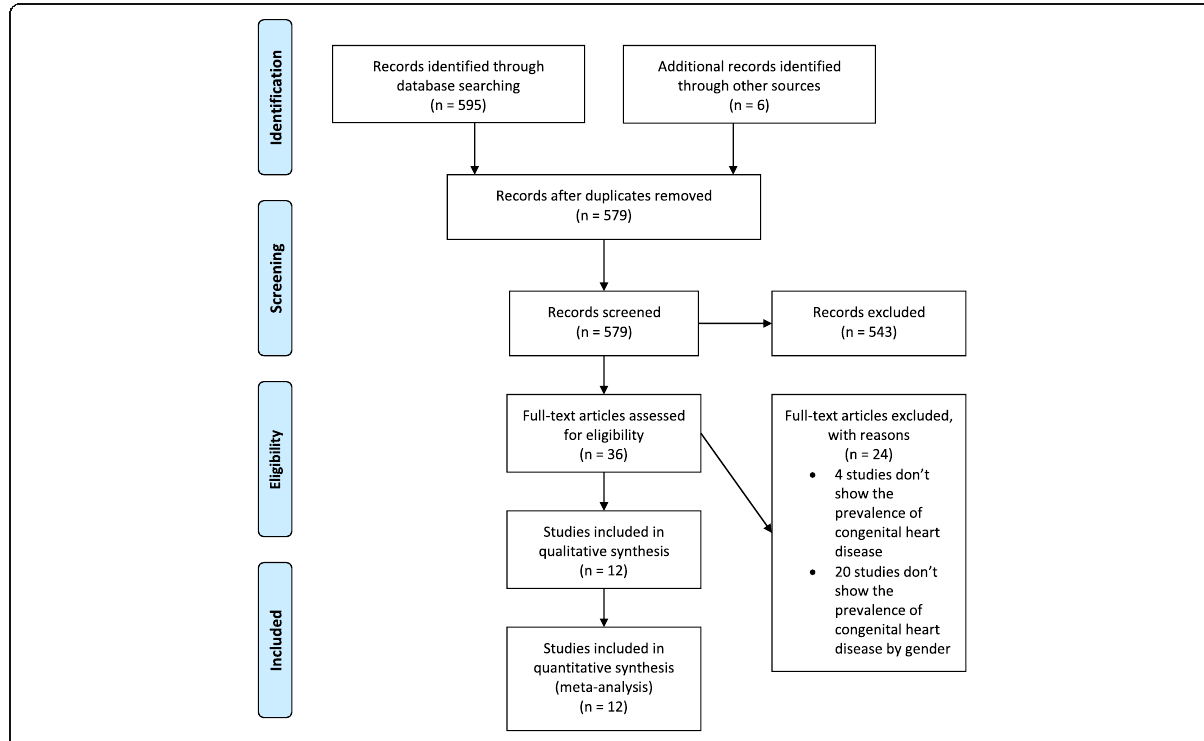
Fig. 1 Flow chart of eligible studies for meta-analysis